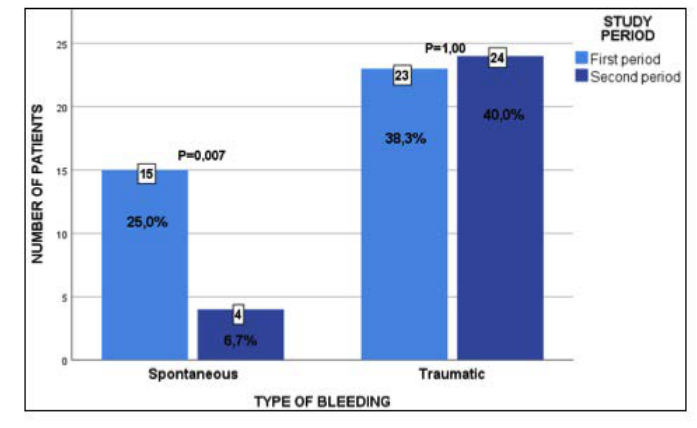
Figure 2. Changes in the type of bleeding: standard comprehensive treatment program vs personalized pharmacokinetic-based treatment